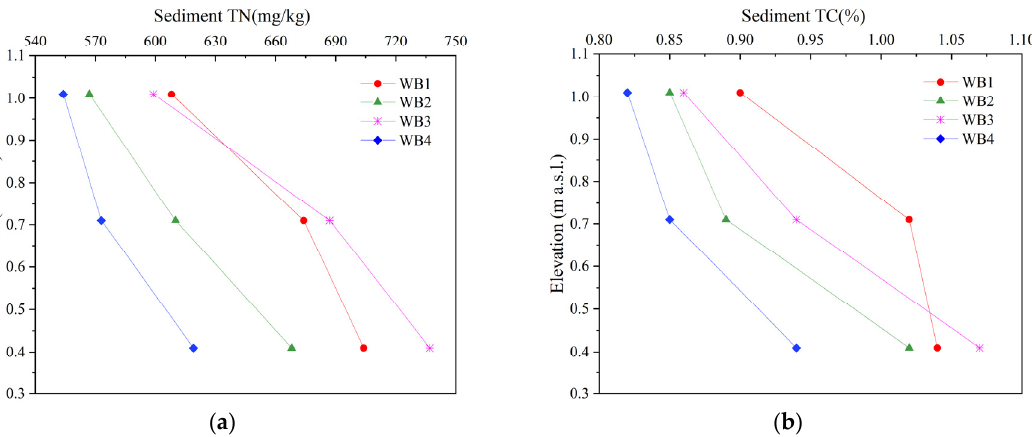
Figure 8. Vertical distribution of the nitrogen and carbon contents of the riparian sediments: ( a ) total nitrogen, TN; ( b ) total carbon, TC.